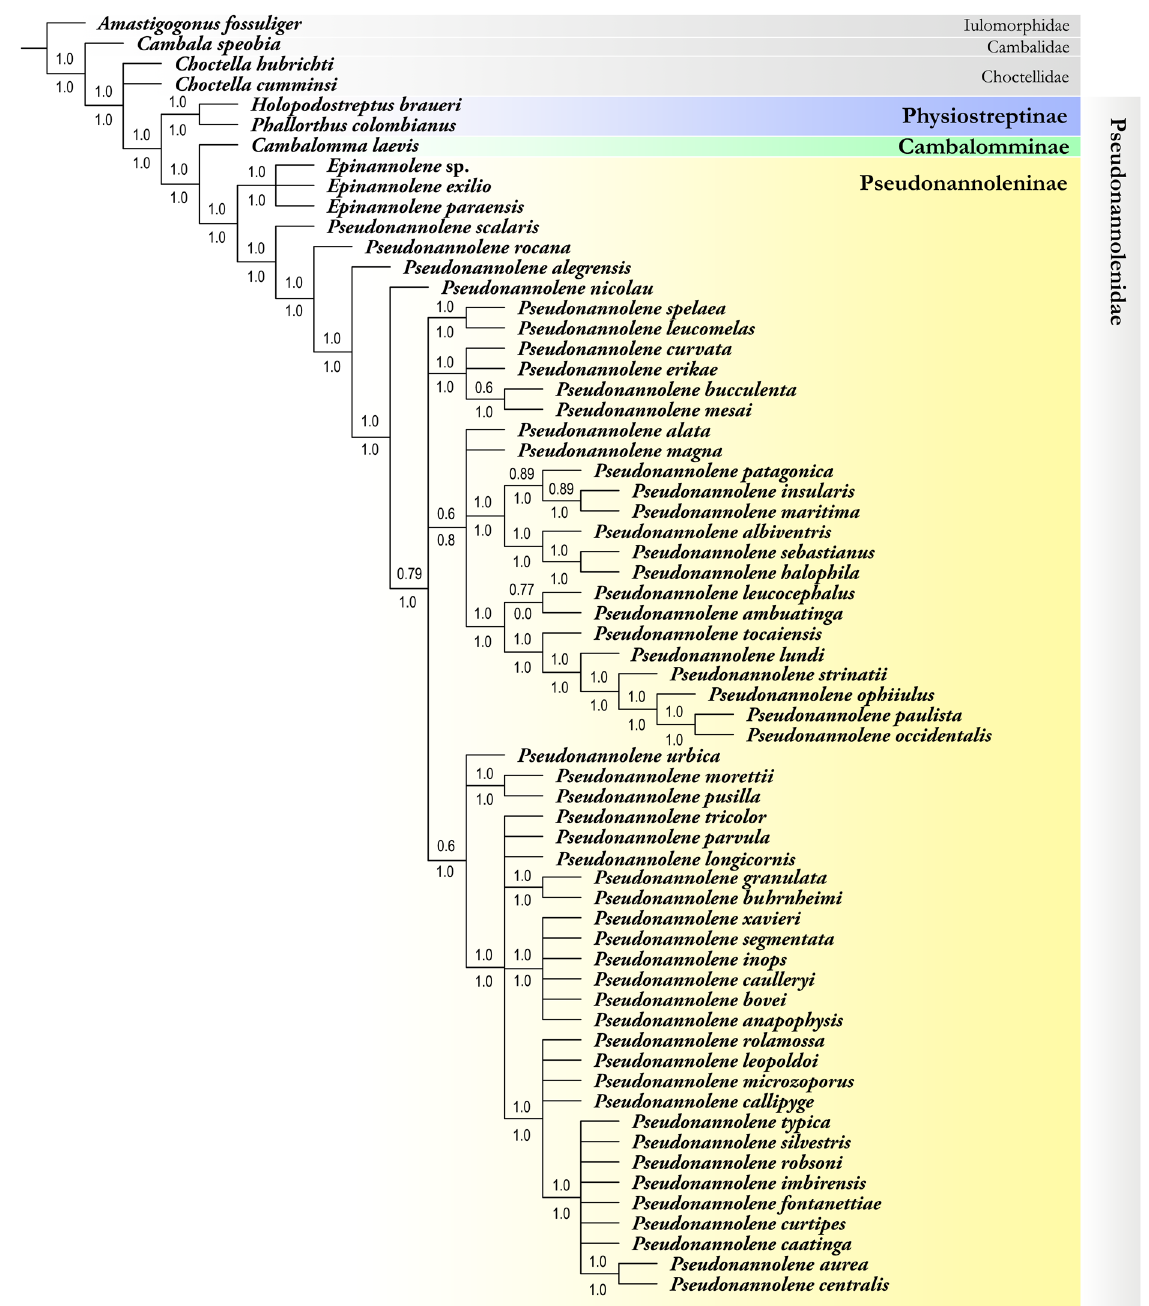
Fig. 9. Majority rule consensus of equally parsimonious trees under implied weighting ( k = 4–7) and recovered only by discrete characters. The values indicated above each clade refer to the frequency of the clade on the majority rule consensus, and the values below refer to the frequency of clades in comparative